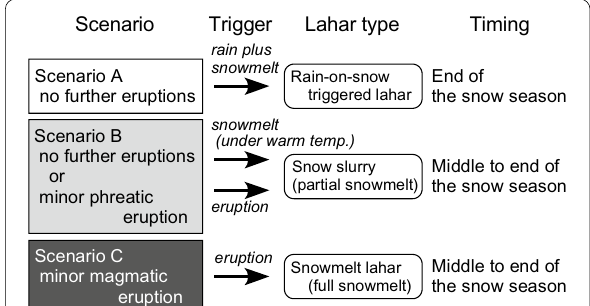
Fig. 10 Scenario models for predicted lahars after the 2018 eruption at Motoshirane